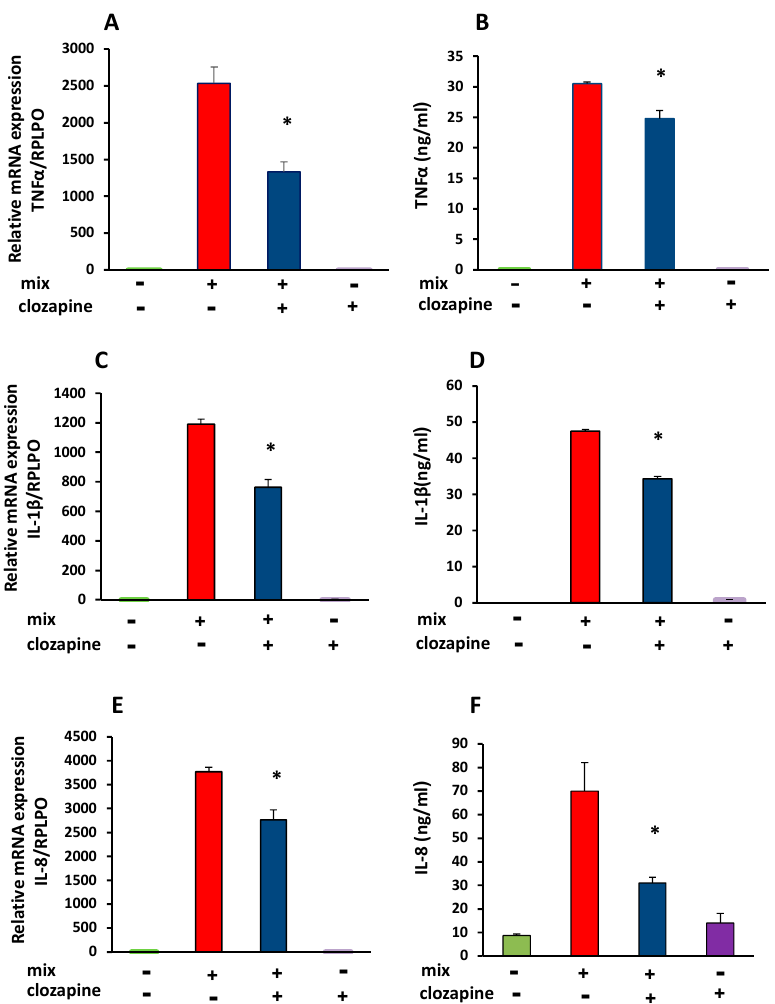
Figure 2. Effects of clozapine on TNF α , IL-1 β , and IL-8 gene expression and protein production. Data are presented as mean ± SEM. ( A , C , E ): RT-PCR analyses of mRNA expression in A172 cells treated with cytokine mix (mix) and clozapine (10 µ M) for 24 h. ( A ) TNF α ( p < 0.001, mix vs. mix with clozapine n = 4 in each group). Data represent the results of one of 5 similar experiments. ( C ) IL-1 β , ( p = 0.003 mix vs. mix with clozapine, n = 4 in each group). Data represent the results of one of 3 similar experiments. ( E ) IL-8, ( p = 0.004, mix vs. mix with clozapine n = 4 in each group). Data represent the results of one of 4 similar experiments. ( B , D , F ): TNF α , IL-1 β , and IL-8 levels in cell supernatants 24 h after stimulation with cytokine mix in the presence or absence of clozapine (10 µM). ( B ) TNF α , ( p = 0.007, n = 3 in each group). ( D ) IL-1 β ( p < 0.001, n = 3 in each group). ( F ) IL-8 ( p = 0.02, n = 4 in each group). Details on all experiments are presented in the text. * p < 0.01 vs. mix. mRNA by 36.4 ± 5.2%, (mean of 3 experiments, n = 4 in each group; t = 4.78, df = 6 p < 0.001), as well as that of IL-1 β secretion, which was reduced by 27.7 ± 1.4% (t = 8.48, df = 4, p < 0.001, n = 3 in each group). Similar to the findings in the cytokine array assay, a